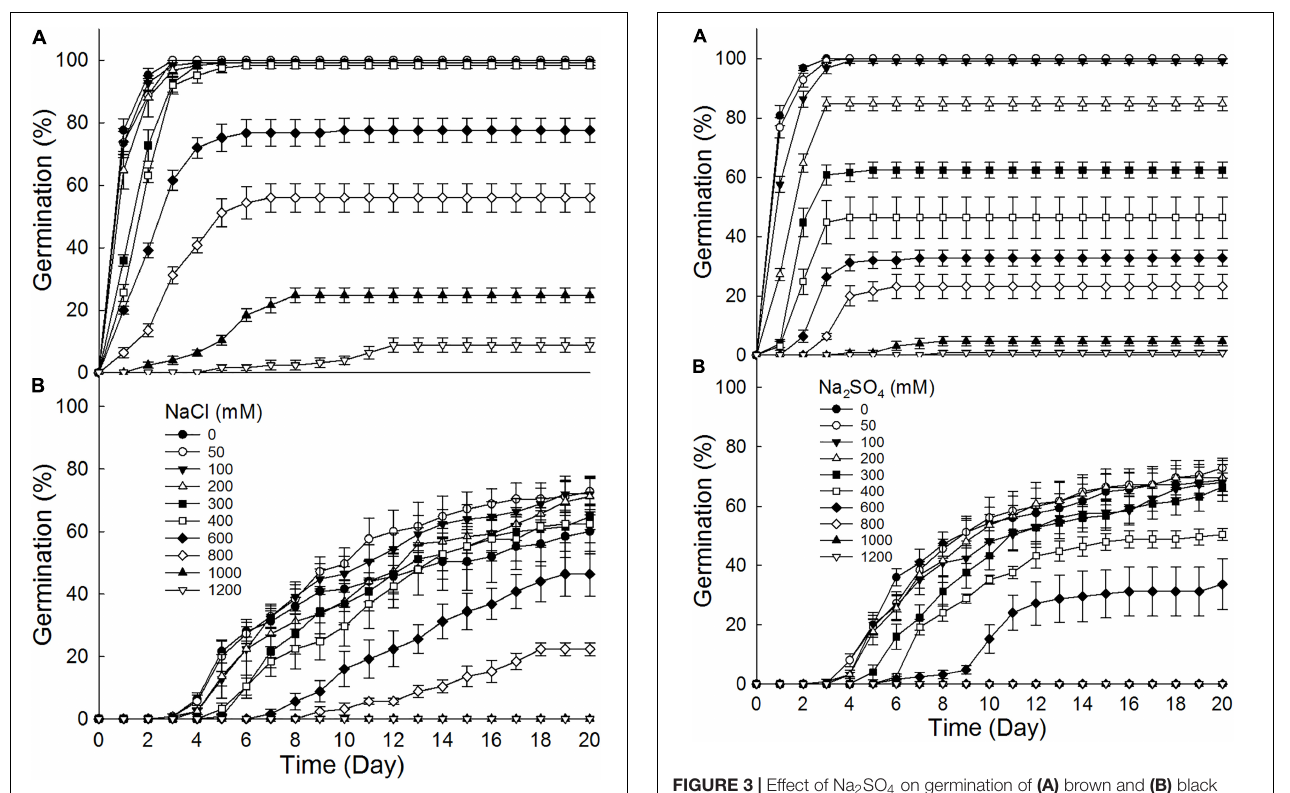
FIGURE 2 | Effect of NaCl on germination of (A) brown and (B) black seeds of S. salsa incubated at 10:25 ◦ C in the 12 h daylight photoperiod for 20 days. For each treatment there were five biological replicates.